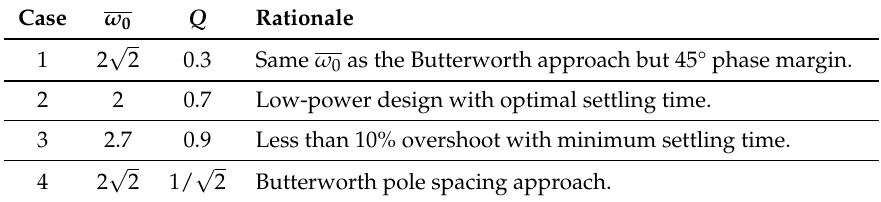
Table 2. Parameters selected for four different design cases for comparison.